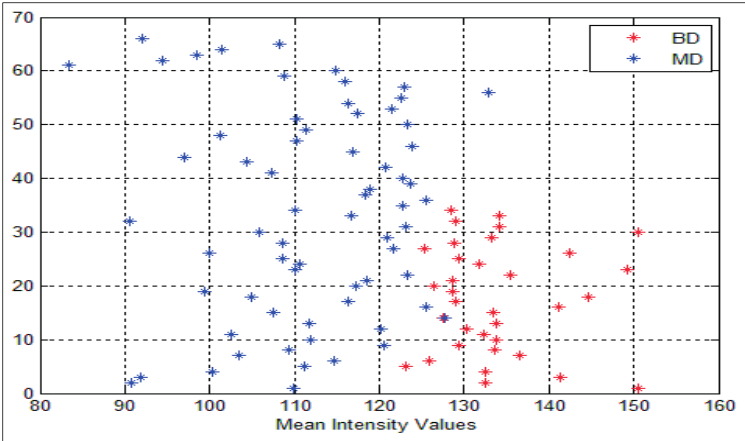
Figure 6. Intensity variances for the nuclei cells, the blue represents the malignant cells (MD) and the red represents the benign cells (BD).